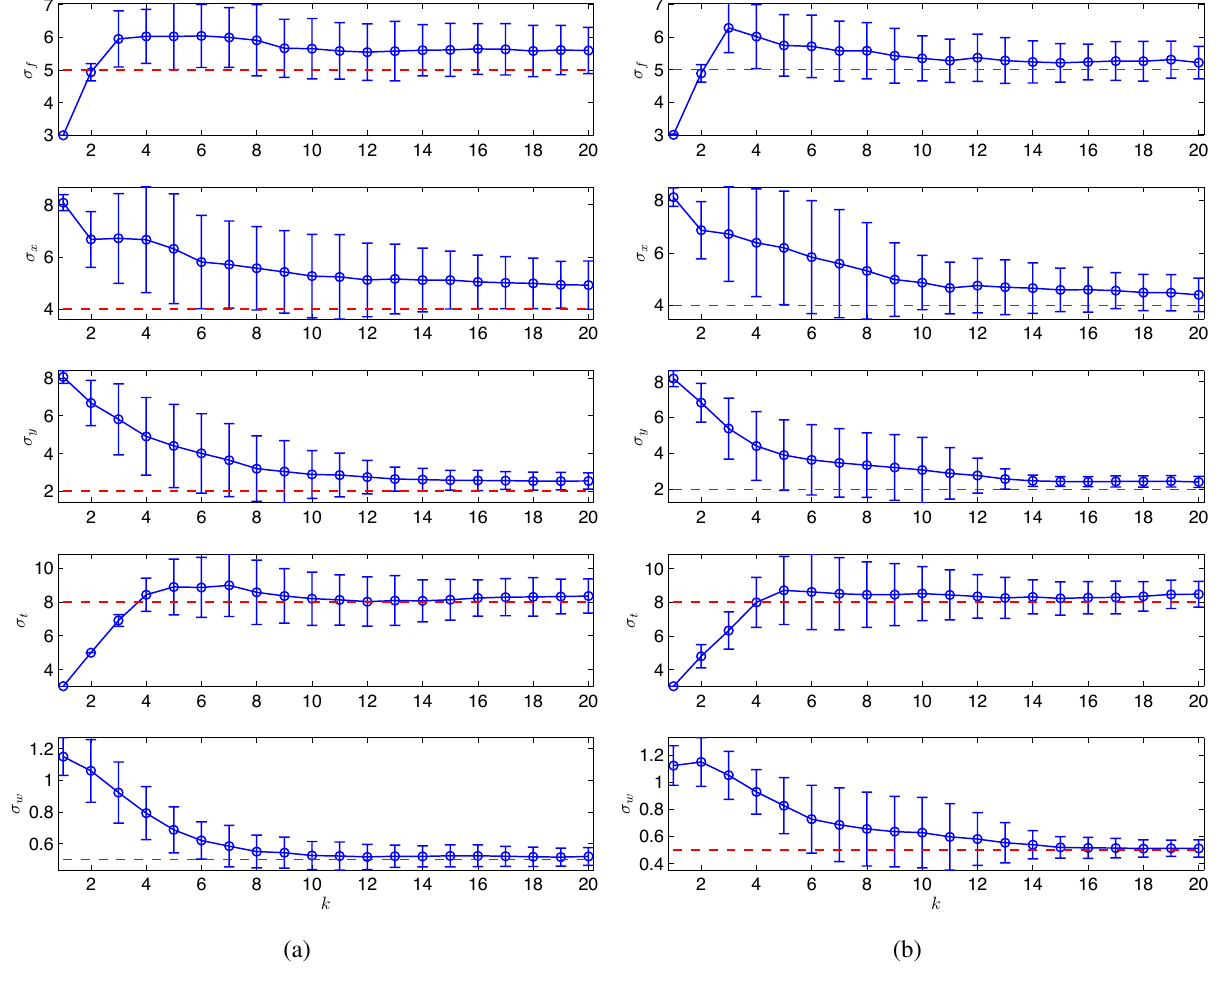
Figure 2. Monte Carlo simulation results ( 100 runs) for a spatio-temporal Gaussian process using (a) the random sampling strategy, and (b) the adaptive sampling strategy. The estimated hyperparameters are shown in blue circles with error-bars. The true hyperparameters that used for generating the process are shown in red dashed